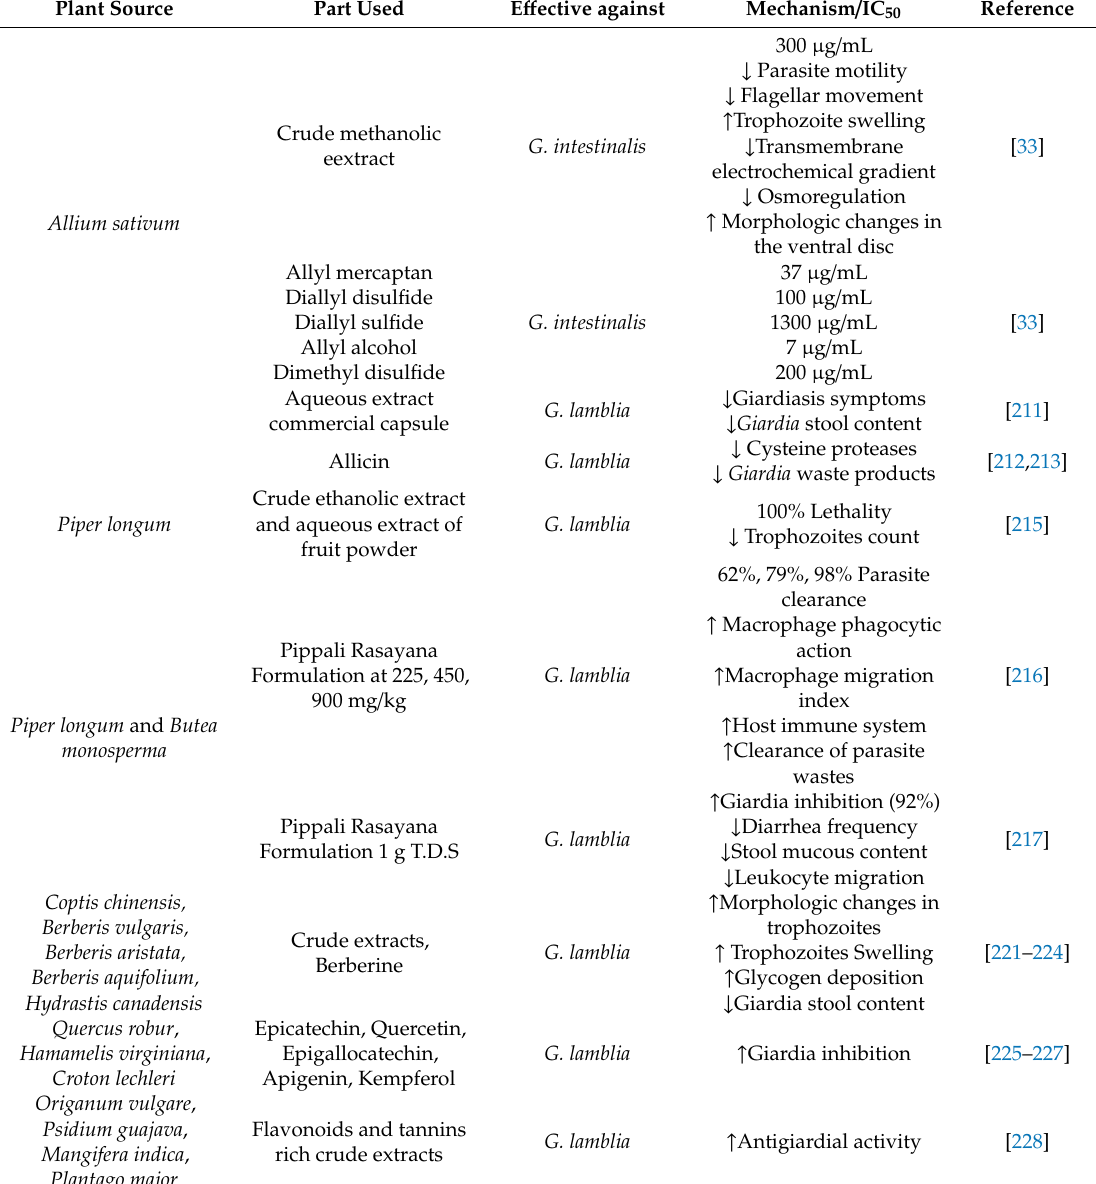
Table 1. Summary of e ff ects of plant extracts and phytochemicals against foodborne parasites. Plant